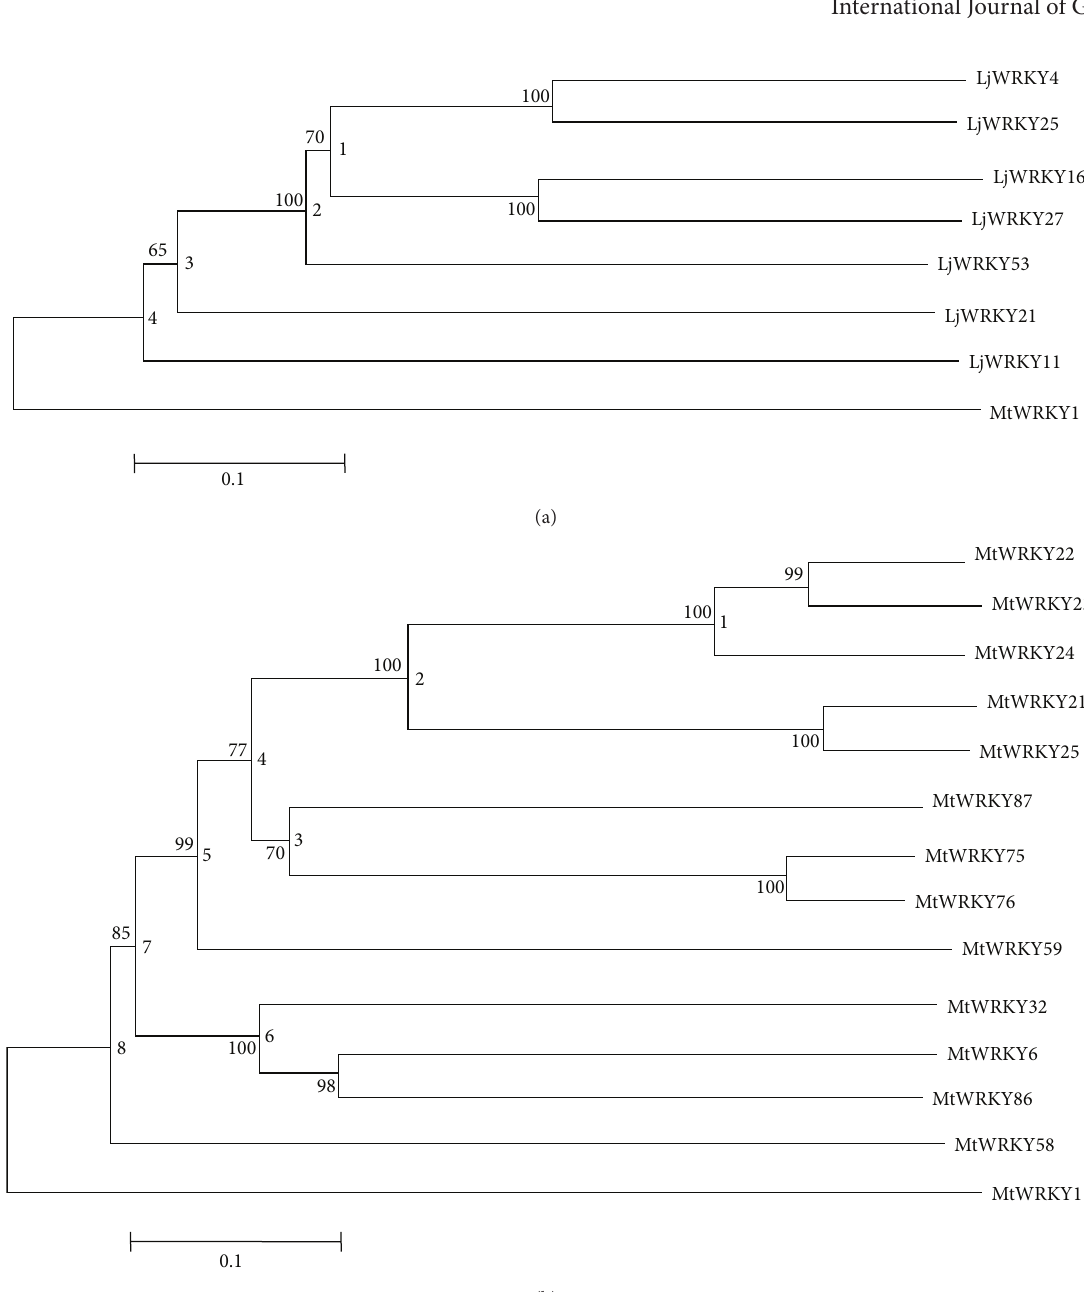
Figure 7: Phylogenetic tree of group III WRKY genes of Lotus japonicus and Medicago truncatula . The phylogenetic trees were constructed using MEGA 4.0 by the Neighbor-Joining (NJ) method with 1,000 bootstrap replicates. Numbers on the left of each internal node represented bootstrap support values and numbers on the right of each node represented the nodes that were used for positive selection analysis. MtWRKY1 gene was used as outgroup. The tree represented phylogenetic relationships among LjWRKY genes (a) and MtWRKY genes